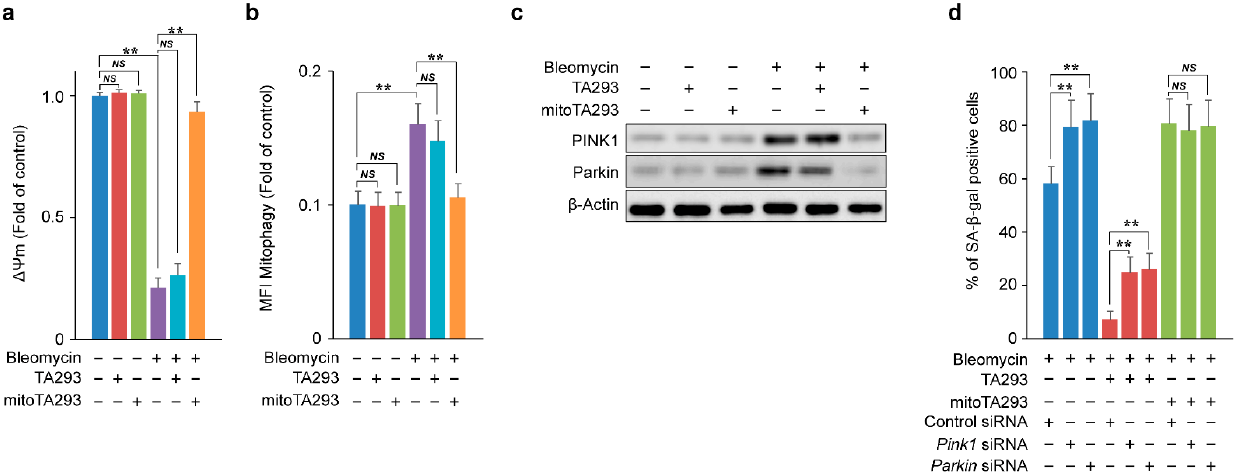
Figure 6. Effects of TA293 and mitoTA293 on mitochondria in BLM-induced PAECs in vitro. ( a ) Mitochondrial membrane potential ( ∆Ψ m). ( b ) Quantification of mitophagy. ( c ) Expression of PINK1 and Parkin visualized by western blotting. ( d ) Effects of Pink1 and Parkin siRNAs on cellular senescence. PAECs were treated with saline or BLM and with vehicle, TA293, or mitoTA293 for 72 h. The data are presented as the mean ± SEM ( n = 5 per group); ** p < 0.01; NS , not significant.